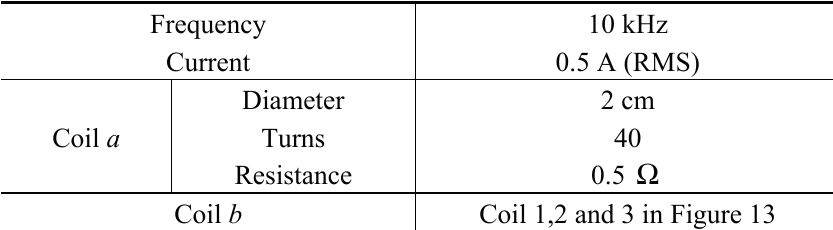
Table 4. Experiment